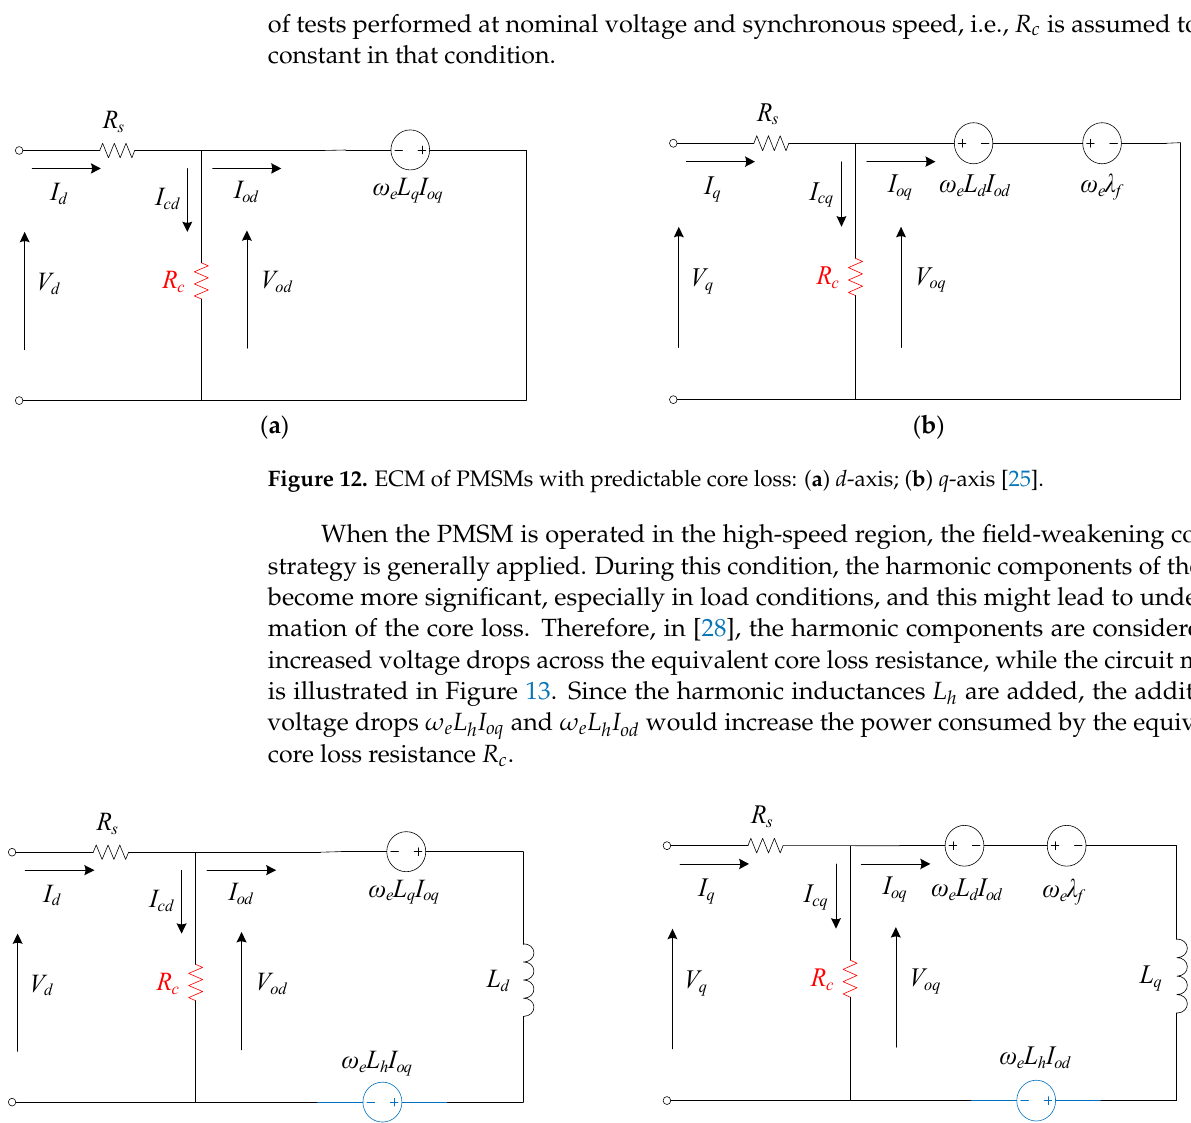
of tests performed at nominal voltage and synchronous speed, i.e., R c is assumed to be a